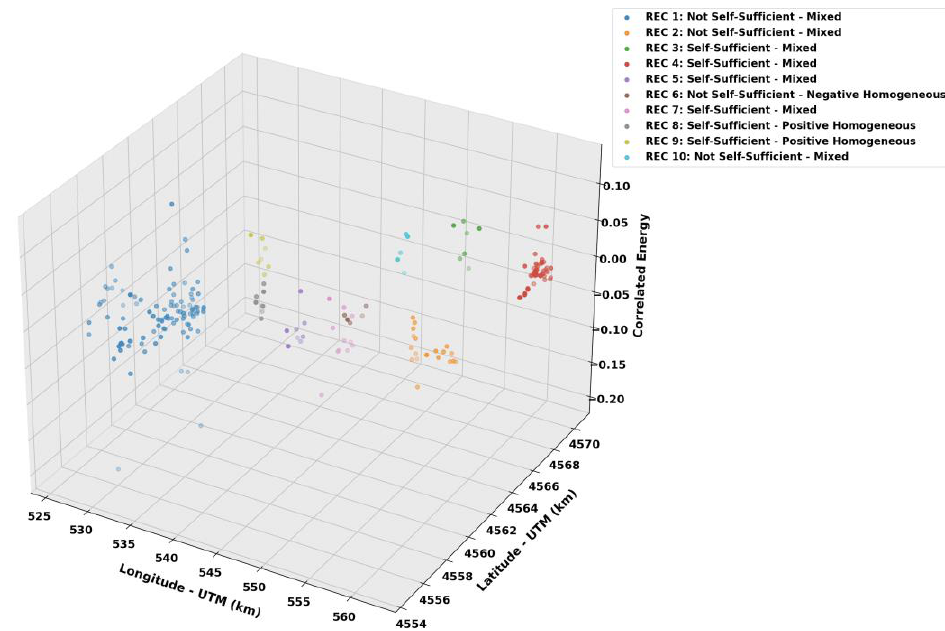
Figure 22. Members distributed by REC — single-link.